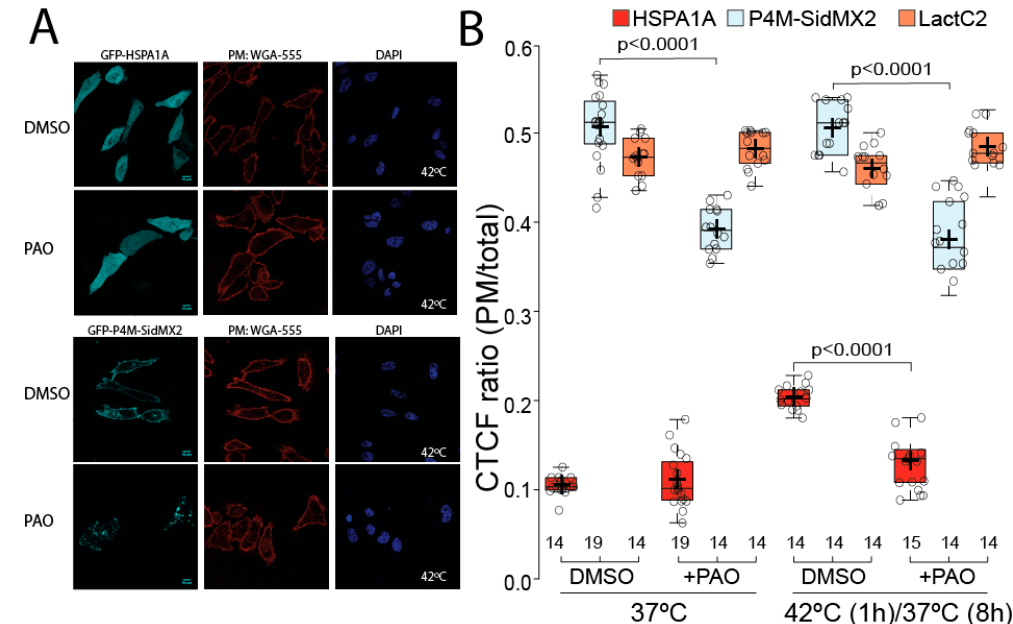
Figure 5. Phenyl arsine oxide (PAO) treatment significantly decreases HSPA1A’s PM localization after heat shock. ( A ) Representative images of HeLa cells expressing GFP-HSPA1A (top panel) and GFP-P4M-SidMx2 (second panel). Cells were either left untreated (DMSO; first row of each panel) or treated with 10nM PAO for 30 min (bottom row of each panel). Only heat-shocked cells are shown. For all cells, the PM was stained with WGA-FA555 and the nucleus with DAPI (second and third picture from the left of each panel). Scale bar = 10 μ M. ( B ) Quantification of the corrected total cell fluorescence (CTCF) as a ratio between the total fluorescence at the PM and the rest of the cell at control conditions and after heat shock in the presence or absence of PAO. The experiment was repeated three times, and the total number of cells (shown as open circles) per condition are shown at the bottom of the graph; box limits indicate the 25th and 75th percentiles as determined by R software; whiskers extend 1.5 times the interquartile range from the 25th and 75th percentiles; crosses represent sample means.